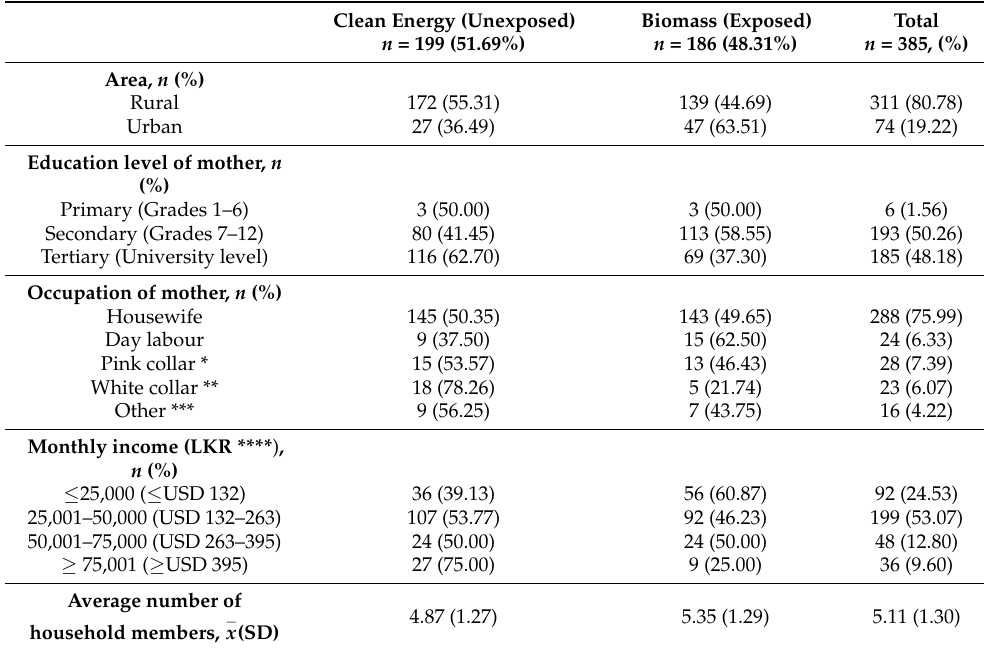
Table 1. Household demographics according to the primary source of cooking fuel used during pregnancy by 385 mothers in Central Sri